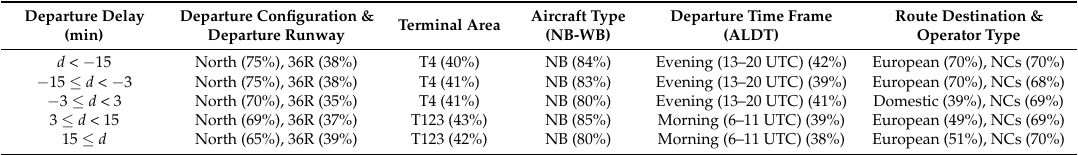
Table 8. Most probable states (and its associated probabilities) for different influence factors, when setting targets of operational time